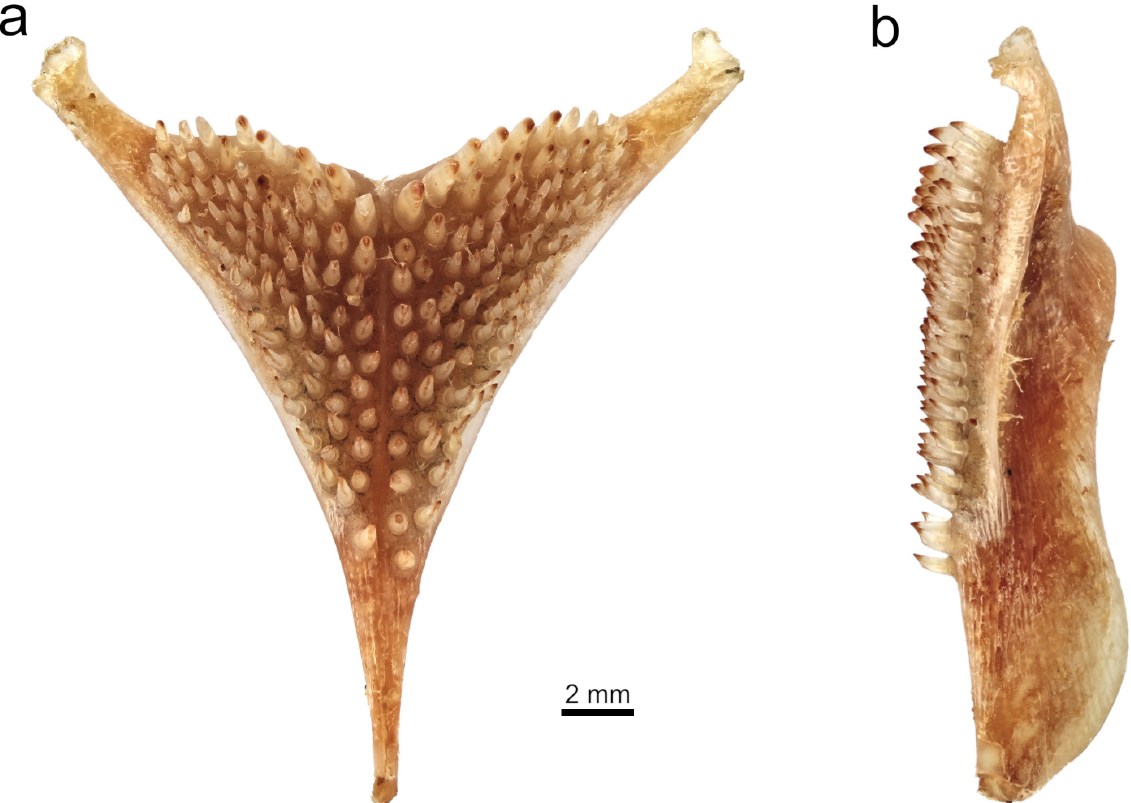
Fig. 40. Haplochromis squamipinnis Regan, 1921 (RMCA 2016.035.P.0254; 182.0 mm SL). a . Dorsal view of the lower pharyngeal jaw. b . Lateral view of the lower pharyngeal